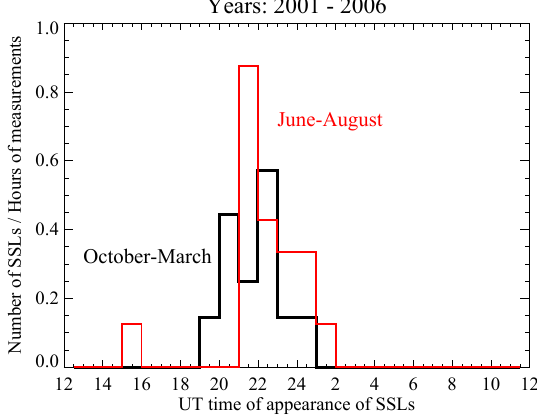
Fig. 10. The number of observed Na number density enhancements per hour of lidar observation time plotted as a function of the time of day of their appearance for summer (red) and winter (black).